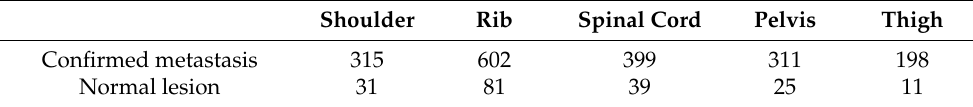
Table 1. Number and position of the metastasis hotspots.